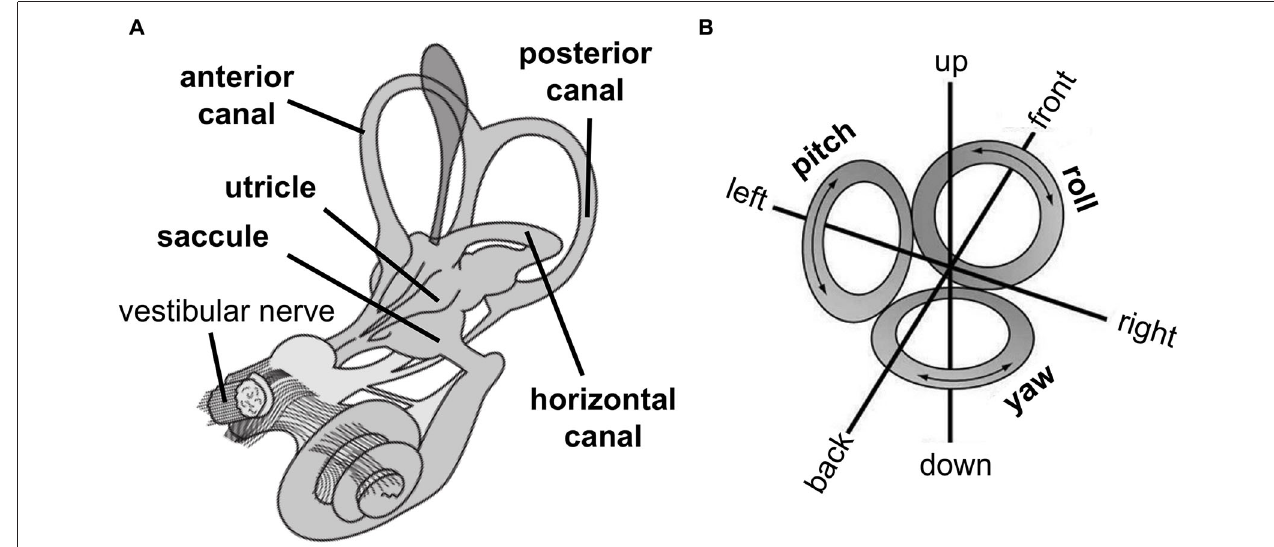
encodes movement in three-dimensional space denoted as linear movements, i.e., in front, back, left, right, up, and down direction (by otolith organs) and rotational movements, i.e., yaw (by the horizontal canal) and pitch and roll (by both anterior and posterior canal). (Images are derivatives of works by NASA, licensed under creative